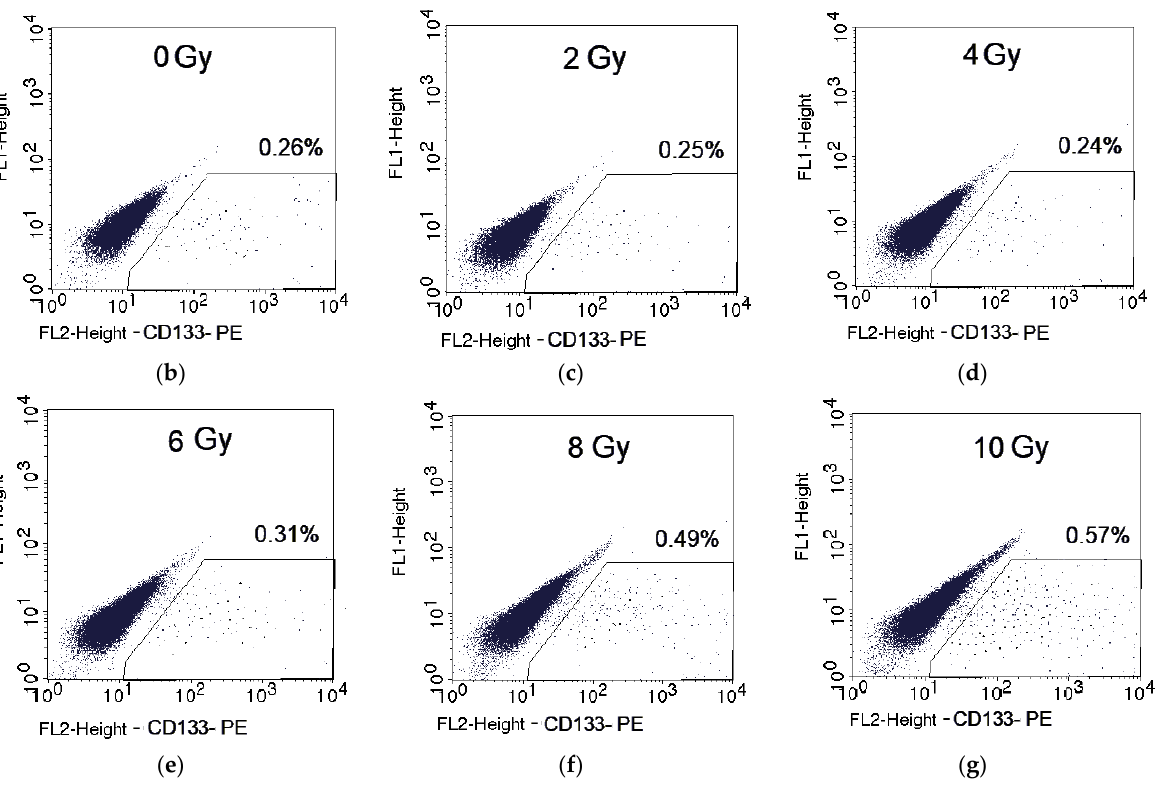
Figure 2. Representative dot plots for fluorescence of SiHa cells in the control of nonspecific binding ( a ) and after staining of unexposed ( b ) and exposed samples to fractionated γ -radiation at various TDs ( c – g ) with phycoerythrin (PE)-labeled antibodies to CD133. The region of CD133 + cells is highlighted and their percentage is indicated in each plot.